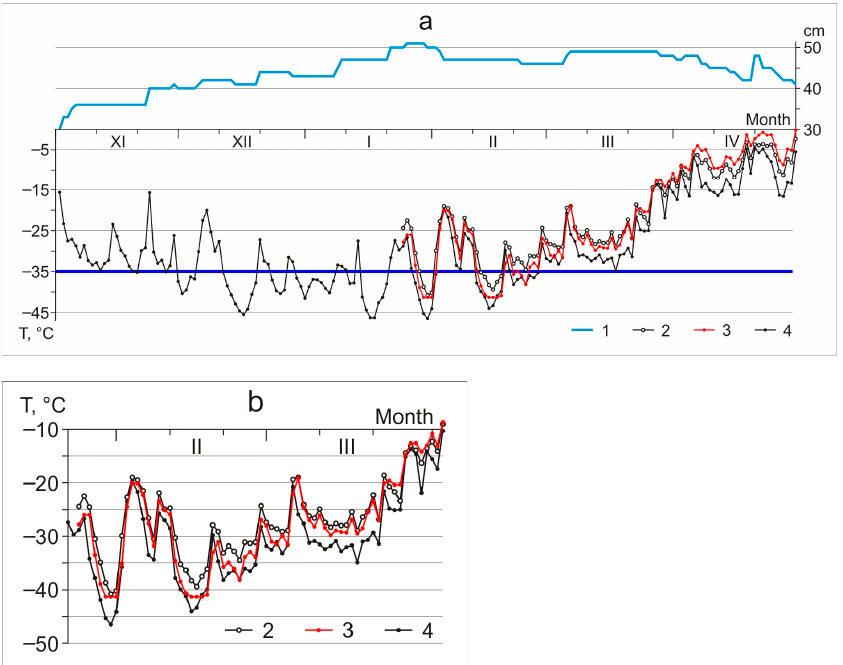
Figure 5. Wintering conditions for the Aglais urticae in the basin of the upper reaches of the Kolyma River (on the territory of the Kolymskaya weather station). Dynamics: ( a ) depth of snow (1); minimum temperatures in two unheated cabins (2,3); and daily minimum air temperatures (4). ( b ) Dynamics of the mentioned temperatures on a large scale.